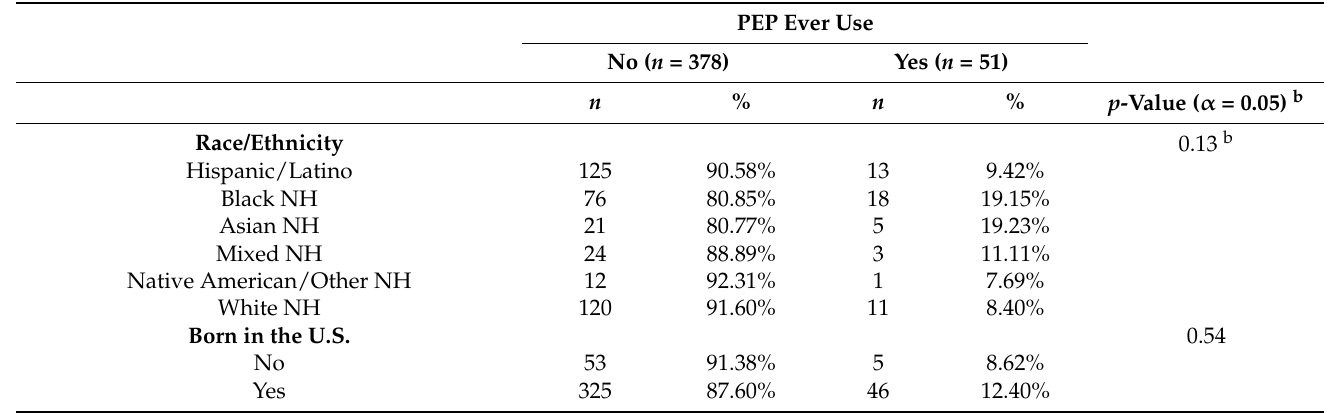
Table 2. PEP ever use by participant characteristics, PrEP ever use, and recent methamphetamine use ( n = 429) a